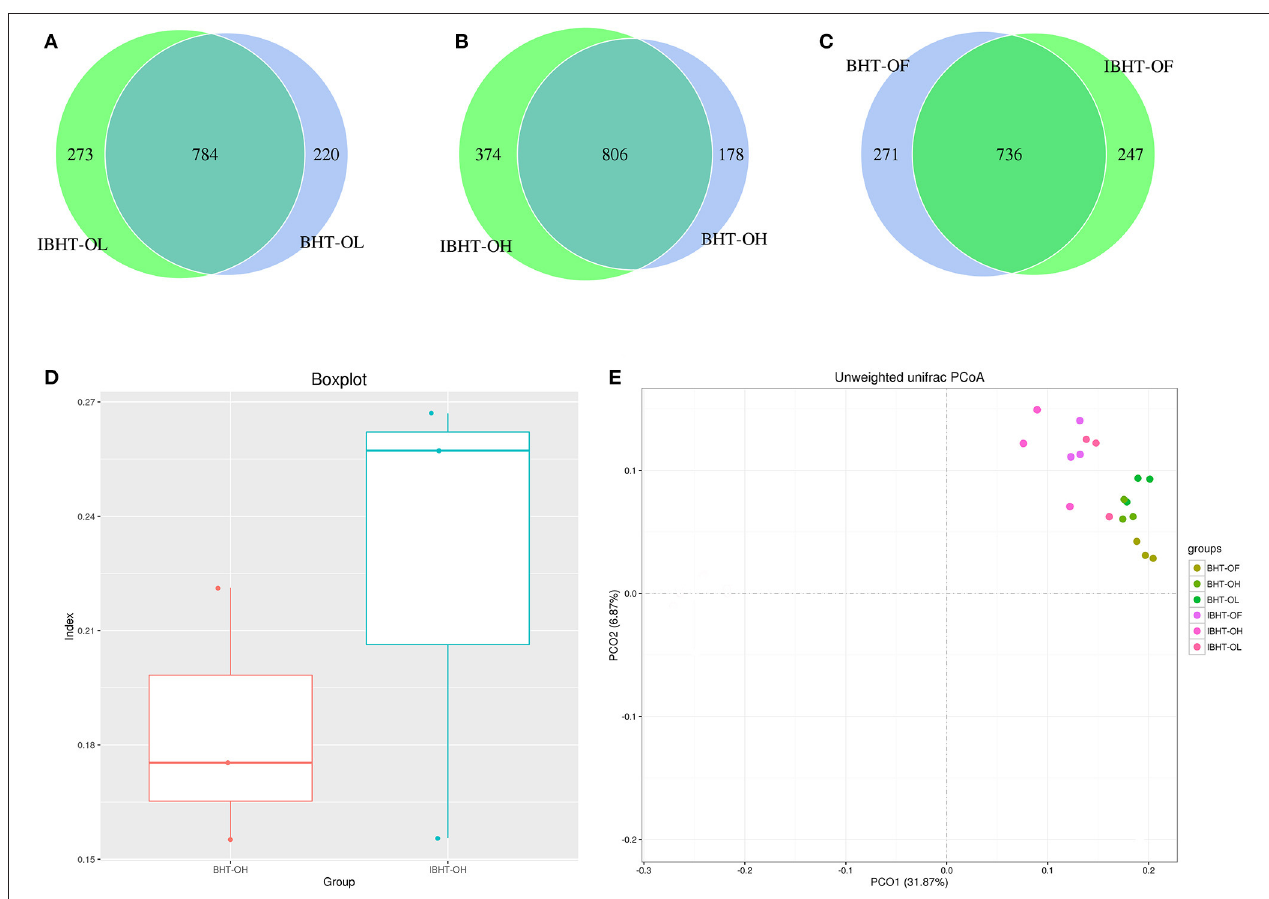
FIGURE 3 | Comparison of OTUs (operational taxonomic units), PCoA (principal coordinates analysis), and gut microbial diversity between Bian Hens–20 weeks (BHT) and ISA Brown Hens–20 weeks (IBHT). (A-C) The Venn diagram of comparison of OTUs between BHT and IBHT. The overlapping parts show the number of OTUs shared by two groups, while the values on either side are the numbers of unique OTUs in each group, respectively. (D) Box plot of β -diversity between BHT and IBHT. (E) Principal coordinates analysis (PCoA) of samples of BHT and IBHT. Different color dots represent samples from different groups of two